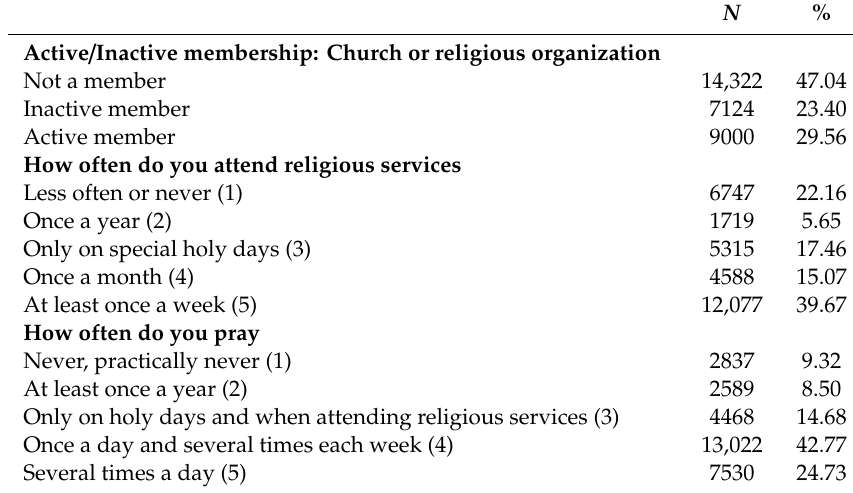
Table 5. Distribution of frequencies relating to religious